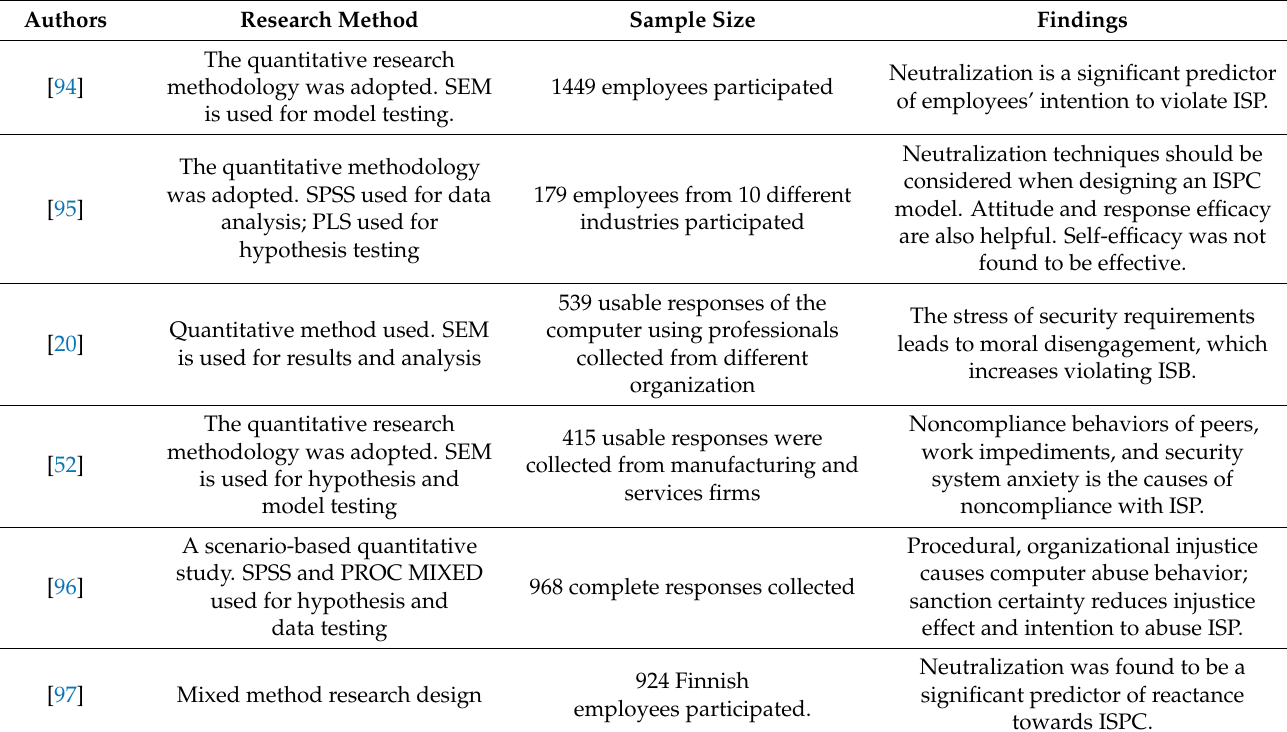
Table 11. Studies on SRS, neutralization, and